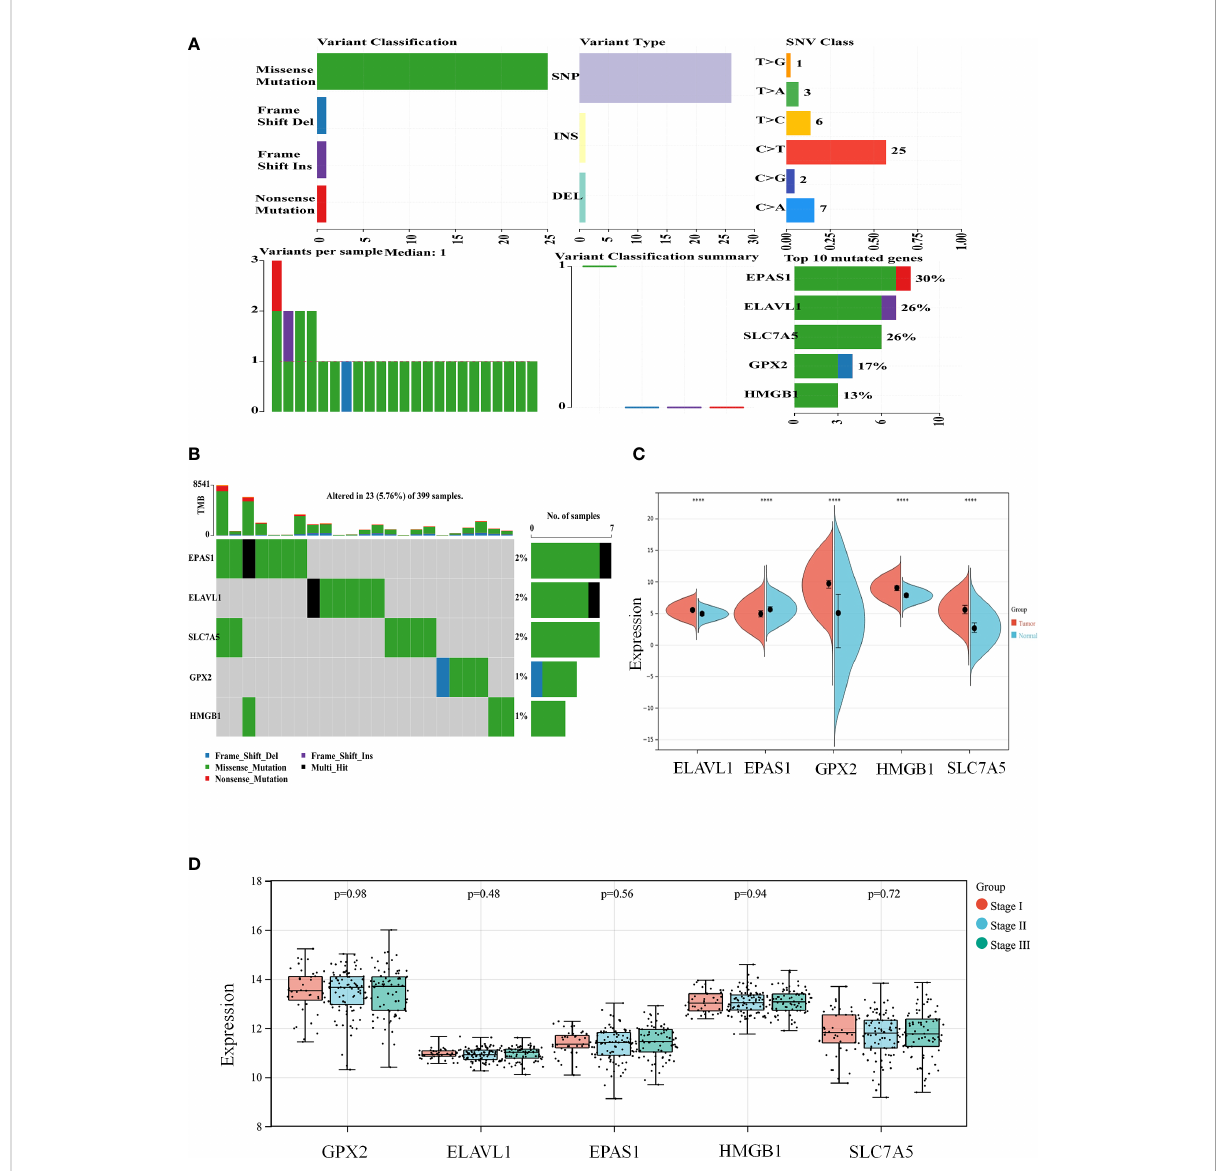
FIGURE 7 The expression of key genes plays an important role in the development and progression of colon cancer. (A, B) Mutation correlation analysis of key genes. (C) Expression of the key genes in colon cancer tissues and in normal colon tissues from the UCSC database of colon cancer expression pro fi les. (D) Expression of key genes in different tumor stages. **** P <